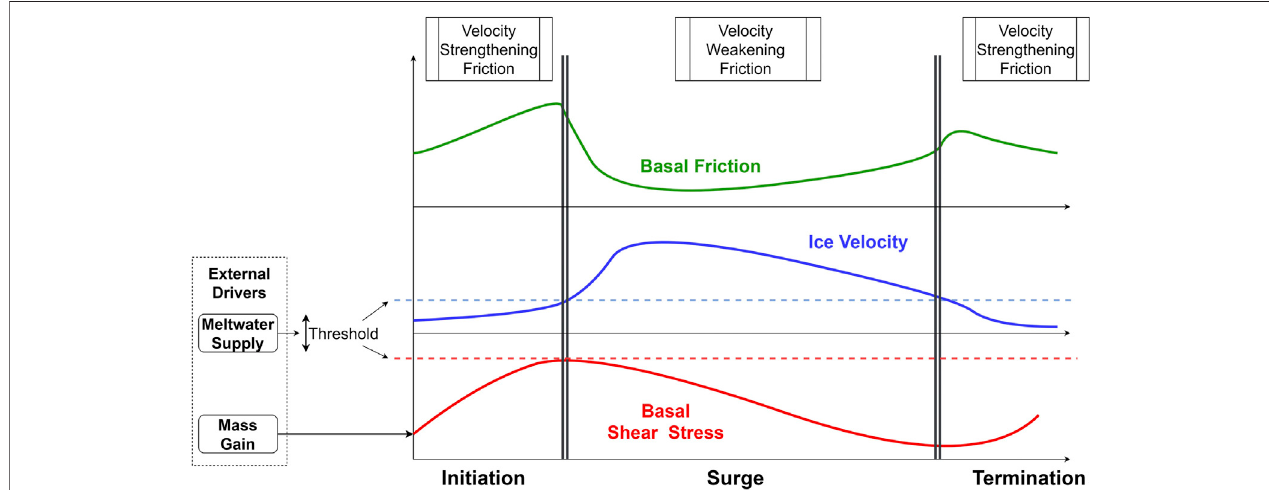
FIGURE 1 | Conceptual and simpli fi ed temporal evolution of mechanism parameters described in Thøgersen et al. (2019). During initiation basal shear stress increaseswithmassgain, fl owvelocityisrestrainedbyvelocitystrengtheningfriction.Waterpresencein fl uenceslevelofthresholdinshearstressandvelocitythatresults in velocity weakening friction. During surge, friction is low, velocity ishigh, driving stress gradually decreases. At low driving stress velocity decreases and friction returns tovelocitystrengtheningthusfollowingbasalsliprates,surgeisterminated.Viewisstronglysimpli fi ed:detailofcavityformation,spatialpropagationandin fl uenceof valley side friction not included